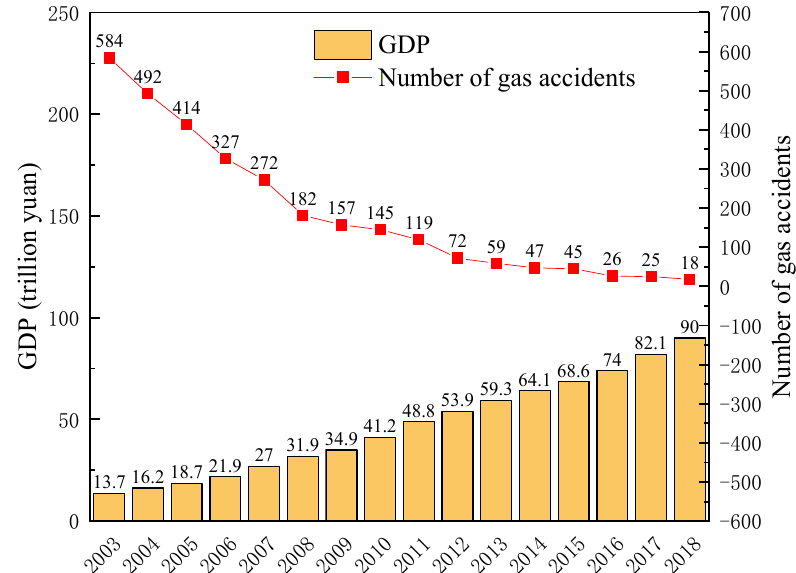
Figure 14. Changes in the number of gas accidents and GDP.